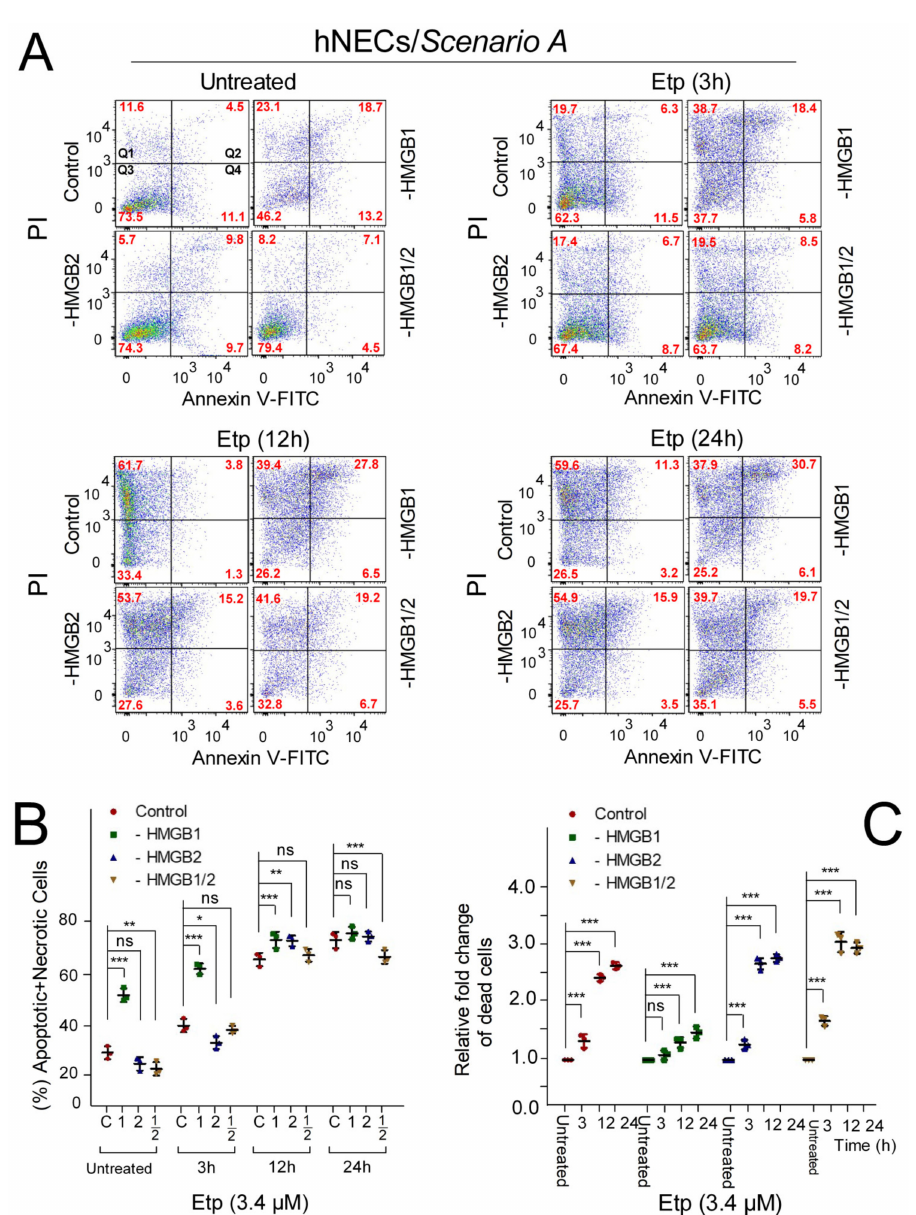
Figure 5. The impact of HMGB1 / 2 KD on the apoptosis of etoposide-treated hNECs prepared according to Scenario A. ( A ) Representative dot plots showing Annexin V / propidium iodide (PI) binding assays in hNECs upon HMGB1 and / or HMGB2 KD, followed by etoposide treatment for 0-24 h, as analyzed by flow cytometry. ( B ) Percentage of apoptotic / necrotic cells in hESCs from ( A ). ( C ) Relative fold change of total cell death among populations of control or HMGB KD hNECs (control cells from each of the cell types were set as 1). Error bars represent the mean and SD of three independent experiments. Data were analyzed using either a Bonferroni post hoc test for the (percentage of apoptotic + necrotic cells) or Tukey’s multiple comparison test for analysis of the relative fold change of dead cells ( p > 0.05 = not significant, ns; * p < 0.05; ** p < 0.01; *** p < 0.001). “C”, cells transfected with empty vector; “HMGB1”, cells upon HMGB1 knockdown; “HMGB2”, cells upon HMGB2 knockdown; “HMGB1 / 2”, cells upon HMGB1 and HMGB2 knockdown. “1”, cells upon HMGB1 knockdown; “2”, cells upon HMGB2 knockdown; “1 / 2”, cells upon HMGB1 and HMGB2